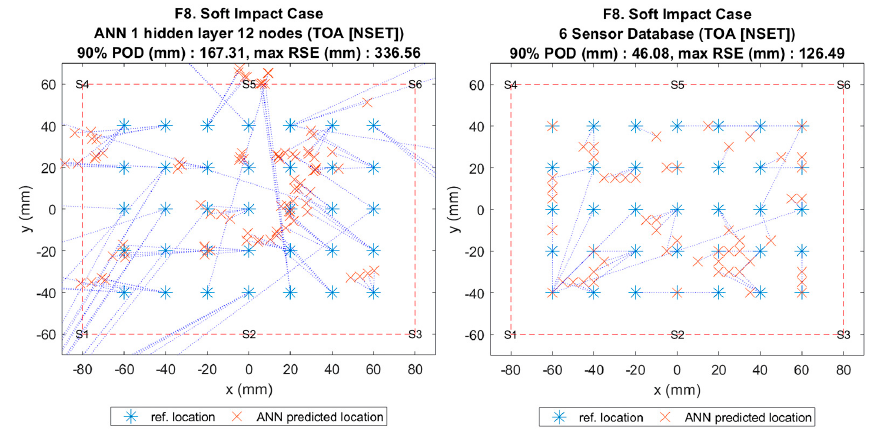
Figure 11. Visualisation of impact localisation for soft impacts (F8) using different methods: ANN (left) and reference database (right).